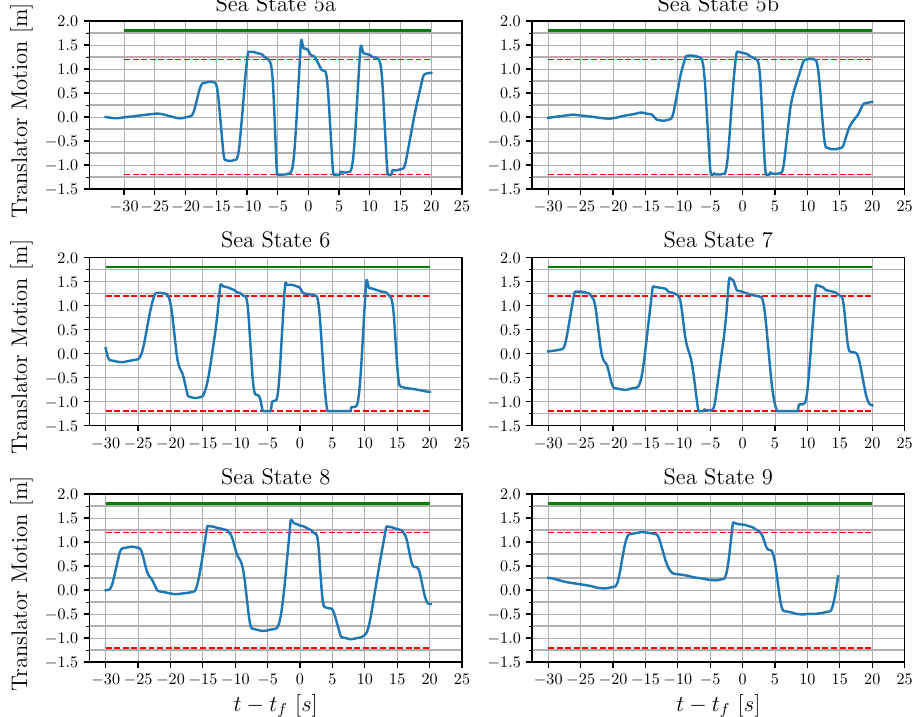
Figure 17. Time series of the translator’s motion during the wave–structure interaction, for all the examined sea states. The translator moves only vertically. The red dashed line indicates the upper and lower free stroke-length (1.2 m), the green line defines the maximum stroke-length (1.8 m). Once the translator exceeds the upper free-stroke length, the end-stop spring starts to compress. During the downward motion of the translator, once the lower free stroke-length of 1.2 m is exceeded, the translator stands on the bottom of the generator and the connection line with the buoy slacks. There is no lower end-stop spring in the present CFD